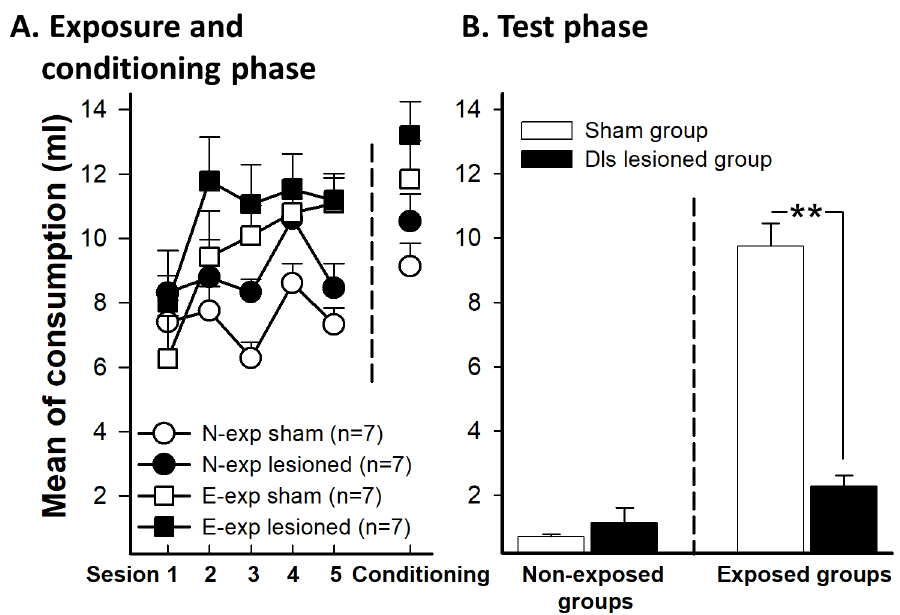
Fig 3. Saccharin intake for sham and dls lesioned animals in E-exp and N-exp groups. E-exp groups was exposedto saccharin for five days before conditioningday. N-exp were only exposedto saccharin the conditioning day. A (left). The graphicshows the five sessions of preexposure phase for the 10.00 am session and (right) saccharinintake duringconditioning phase. B . Effects of dls lesion on mean saccharinintake in extendedexposuregroups (E-exp) to the future CS duringthe test phase. Error bars represent SEMs. Asterisks indicate p < 0.01.N-exp: non-exposed groups, E-exp: extendedexposure groups.